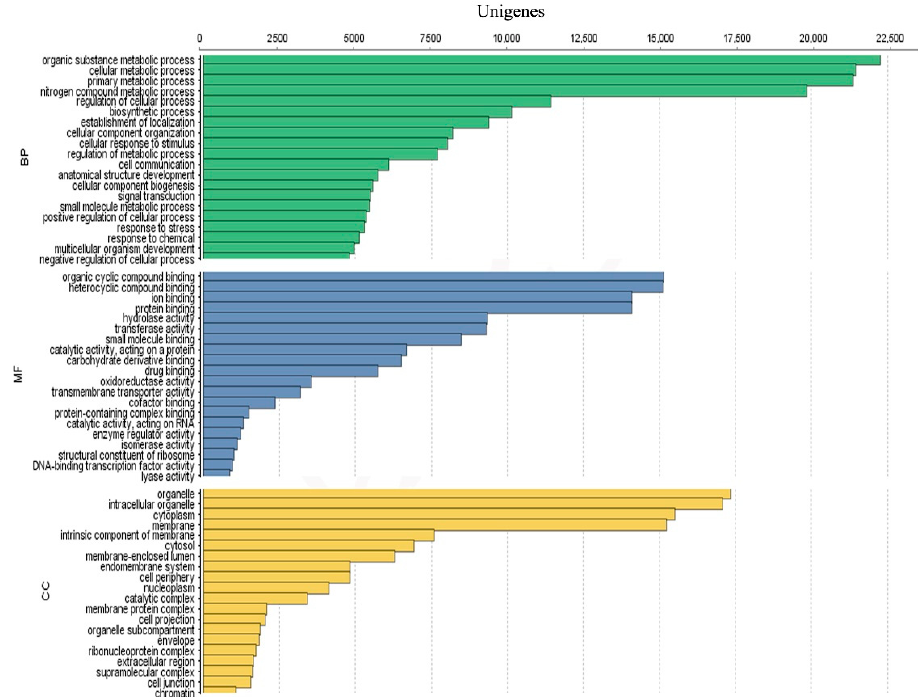
Figure 3. Annotation of GO terms from categories of cellular components (CC), molecular function (MF) and biological processes (BP) for A. minutum unigenes. Only the top 20 terms for each category are shown.